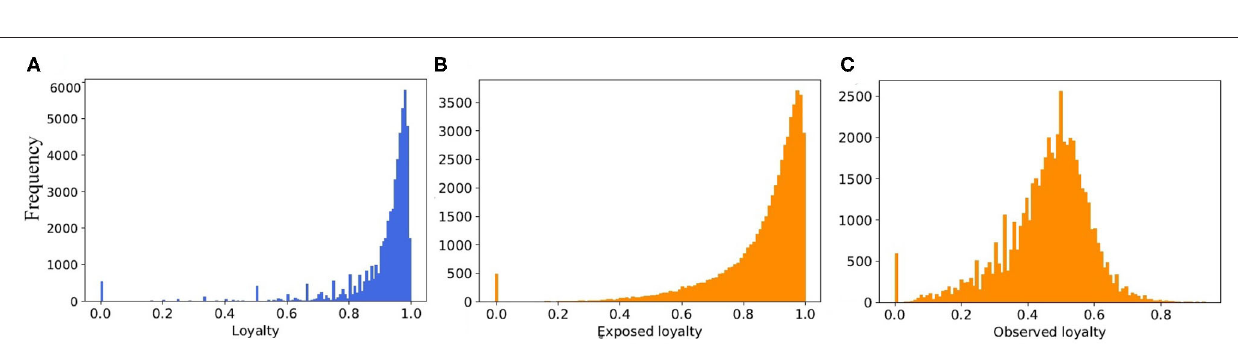
of edges from 6.3 million in temporal view reduced to